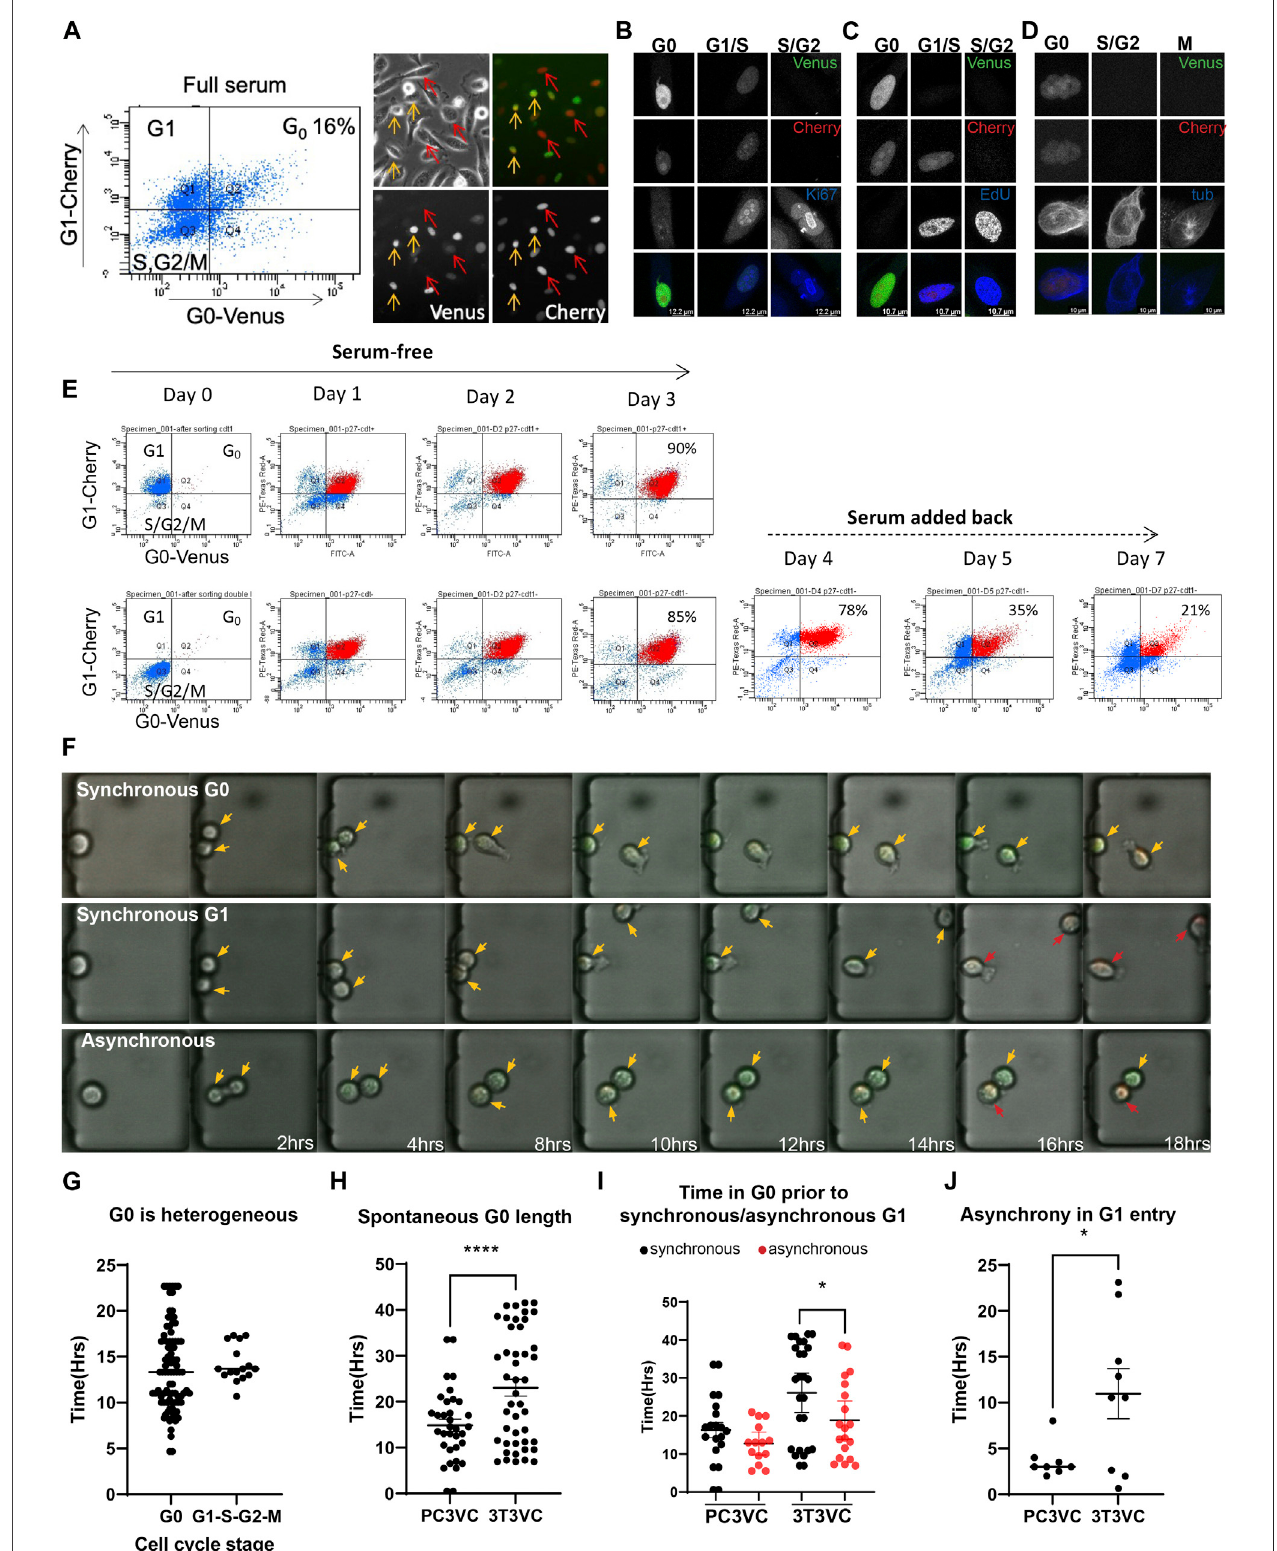
FIGURE 2 | Spontaneous quiescence and asynchronous proliferation-quiescence decisions occur in PC3 cells. (A) G0-Venus and G1-Cherry reporters were transducedintoPC3cellsandacloneexhibitingnormalgrowthrateandstrong,stablereporterexpressionwasisolated.PC3Venus/Cherrycellsexhibitafractionofcells double positive for G0-Venus/G1-Cherry under full serum conditions. Imaging reveals Venus/Cherry double positive cells (orange arrows), Cherry only positive cells (red